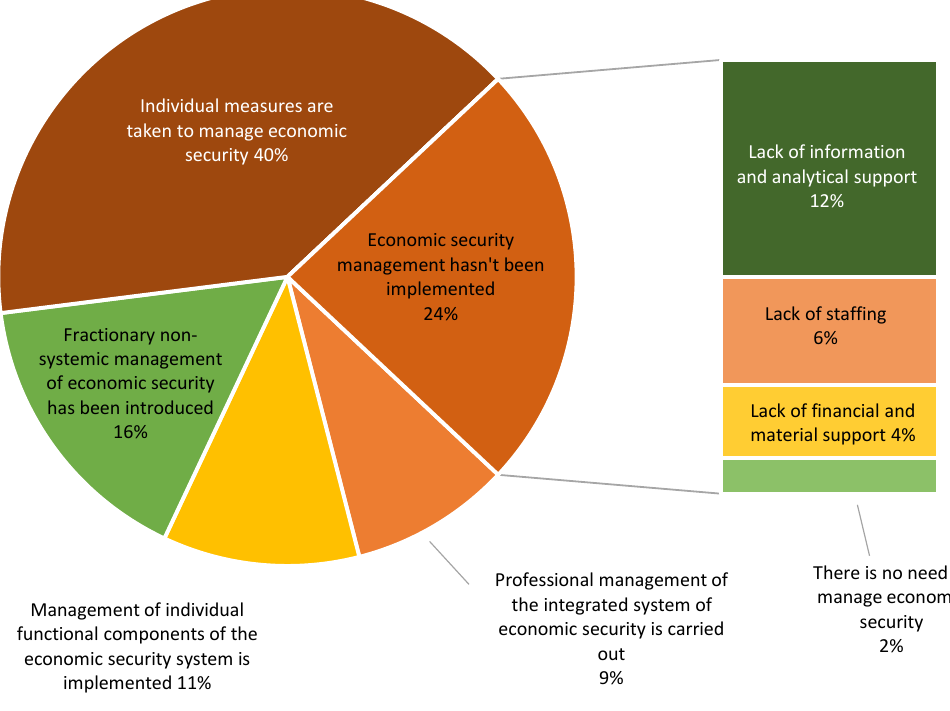
Figure 1. An expert survey results on the state of economic security management of financial intermediaries in